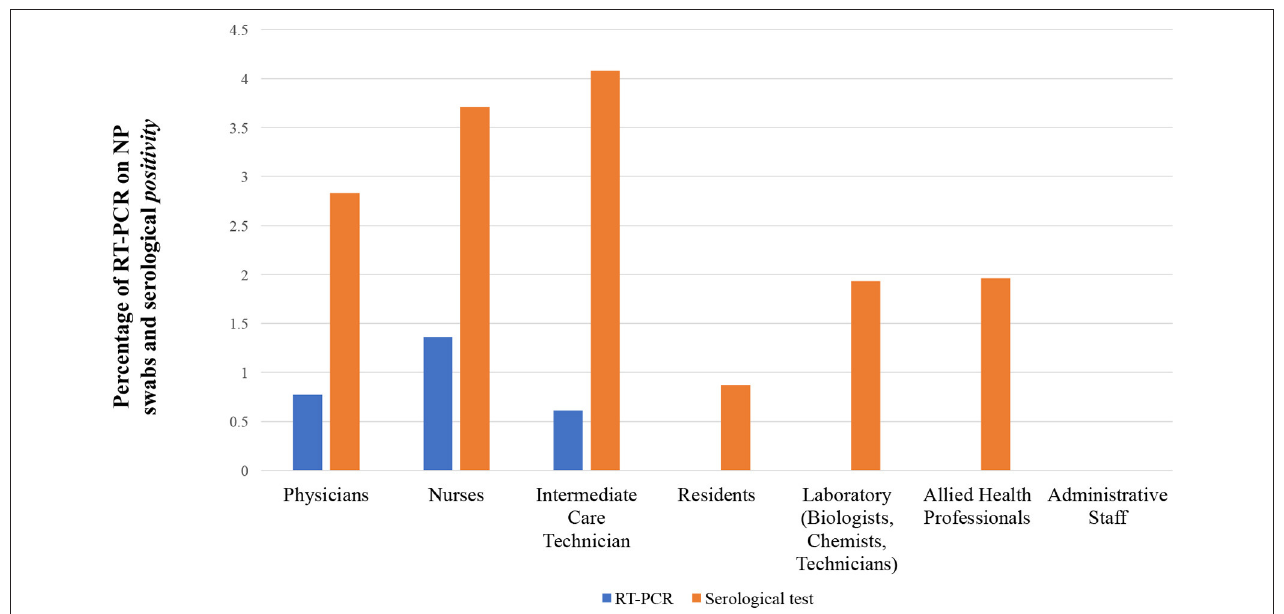
FIGURE 1 | Percentage of HCWs found positive with RT-PCR on NP swabs or rapid antibody test on serological samples (IgG, IgM or both) divided by specific working roles.